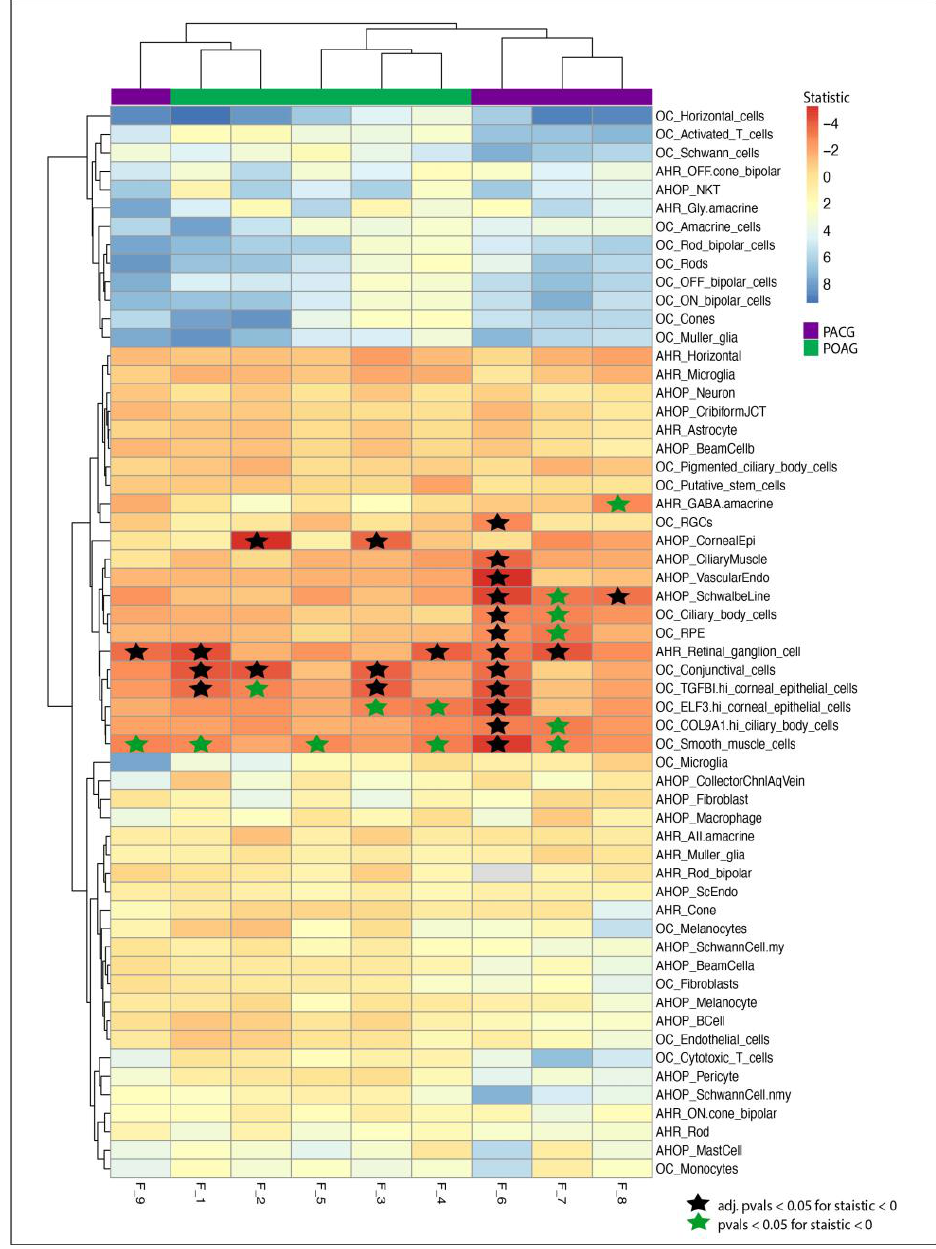
Figure 3. Heatmap showing t statistic for candidate genes expressed in eye tissue. Heatmap and clustering using the t statistic from the t -test of each cell type against all cell types from a study. Negative statistic (Red) represents enrichment of percent cells expressing candidate genes with respect to all tissues. The stars represent p value < 0.05 in tissues with negative statistic. The black stars represent adjusted p values (Bonferroni) less than 0.05. Blue stars represent significant p -values before adjustment.